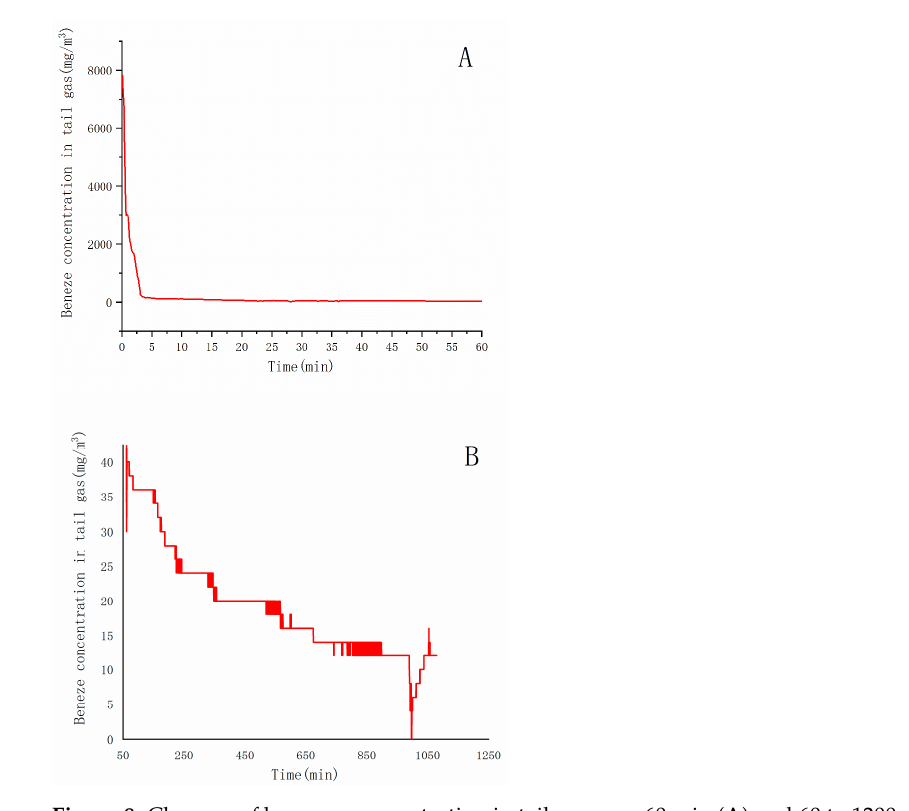
Figure 8. Changes of benzene concentration in tail gas over 60 min ( A ) and 60 to 1200 min ( B ). 3.2. Airflow Changes and Remediation Efficiency In the experiment, the running power of vacuum pump was adjusted to the maxi ‐ mum. It was found that the flowmeter at the tail end of pneumatic pipeline showed only 22.1 L ∙ min − 1 , this was significantly lower than that at idling. After confirming that the pipeline setting and airtightness were all right, it was speculated that the resistance of soil system in the box is large. In the follow ‐ up monitoring, it was found that some obvious changes occurred in the flow rate, so the flow rate was monitored and recorded. The ac ‐ quisition used the mobile phone time ‐ lapse shooting function, it was set to shoot once every 10 min, recording the flow change every 10 min, with a total of 108 records.